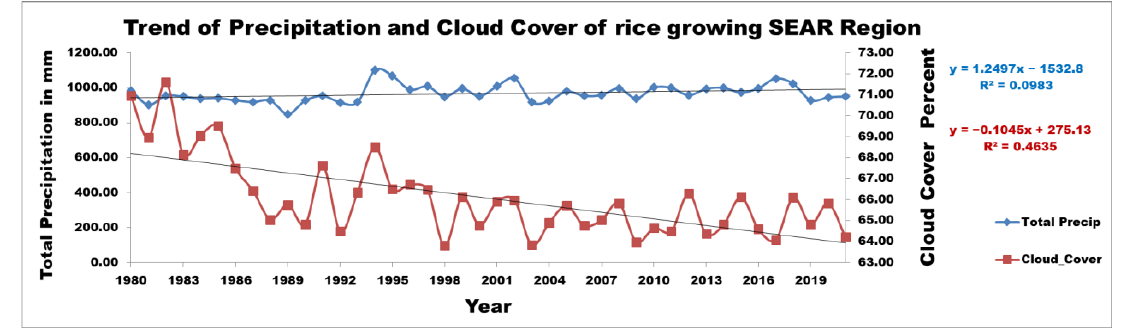
Figure 3. Trend of Precipitation and Cloud Cover for SEAR region.